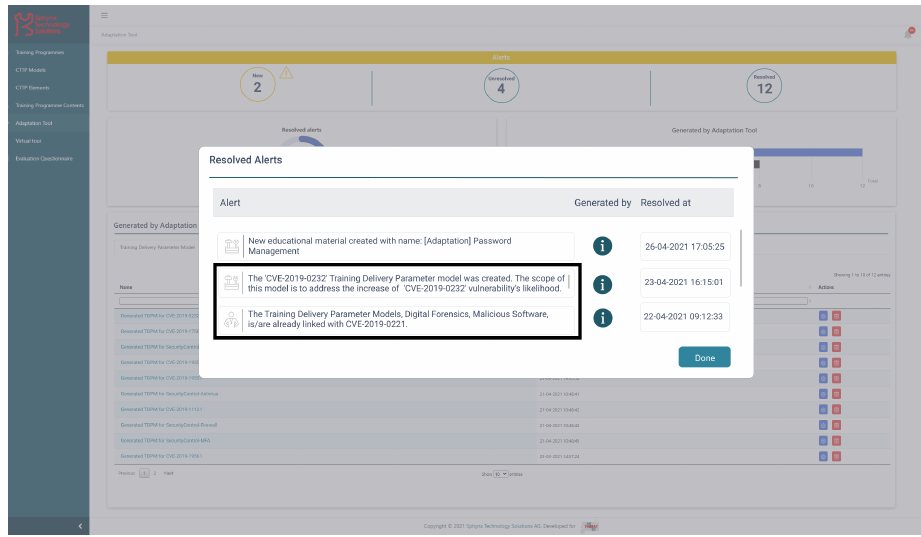
Figure 4. Existing asset vulnerability